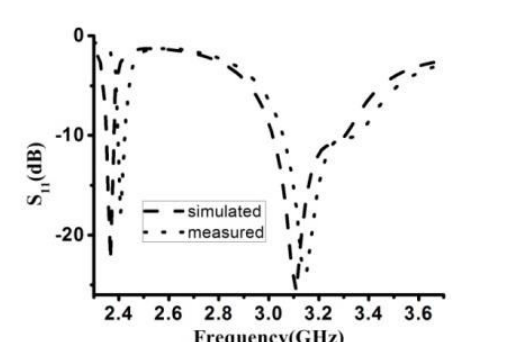
Figure 9: Return loss characteristics of the fabricated antenna The 10-dB return loss bandwidth is 8.22% (3.01- 3.27 GHz) at upper resonating frequency band due to current at patch edges and <1% (resonance at 2.4 GHz only) at